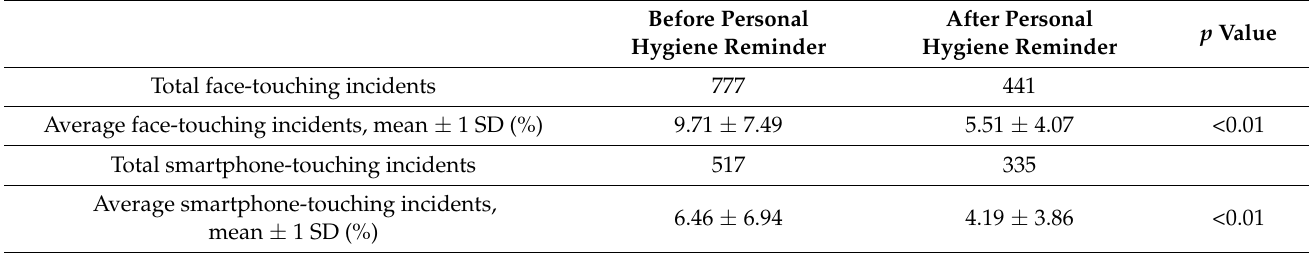
Before Personal After Personal p Value Hygiene Reminder Hygiene Reminder